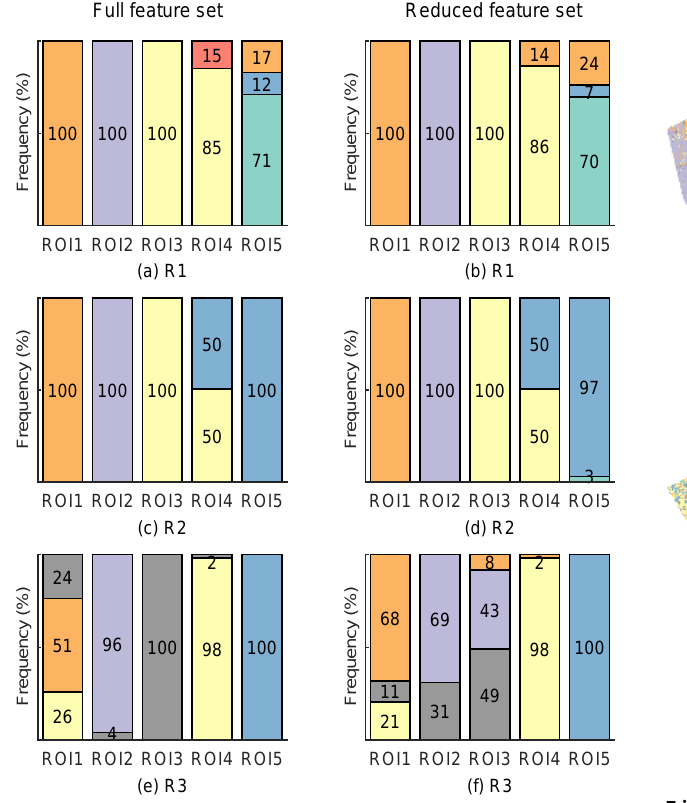
Figure 9. The segments assigned to the pixels in the five regions of interest by the segmentation of the three RADARSAT-2 scenes (R1, R2 and R3). To the left: segmentation with full feature set. To the right: segmentation with reduced feature set.